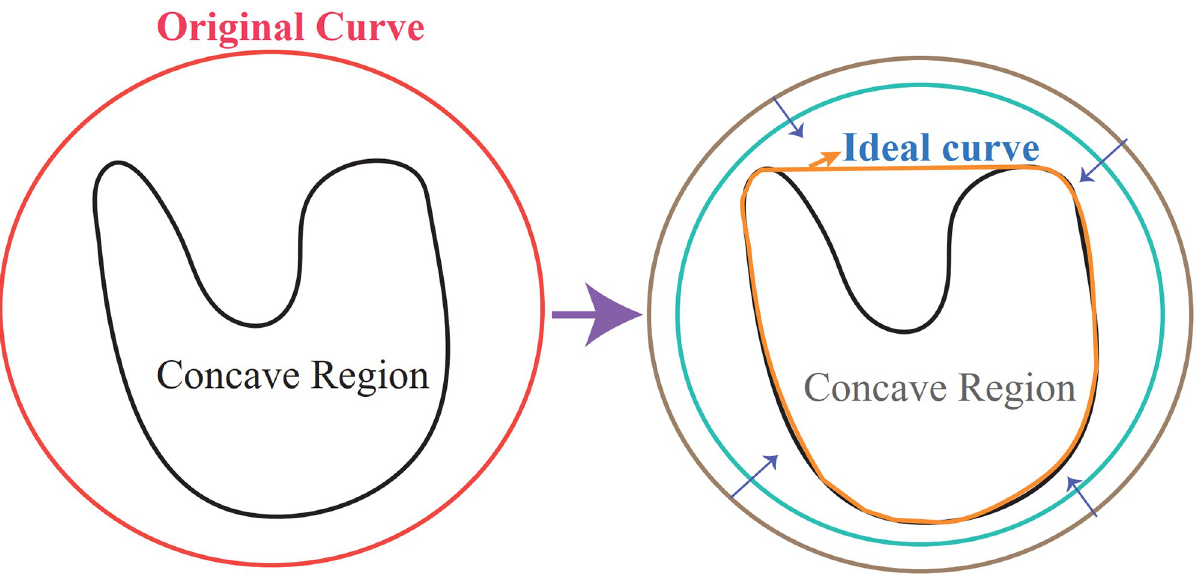
Fig 6. The principle of GVF